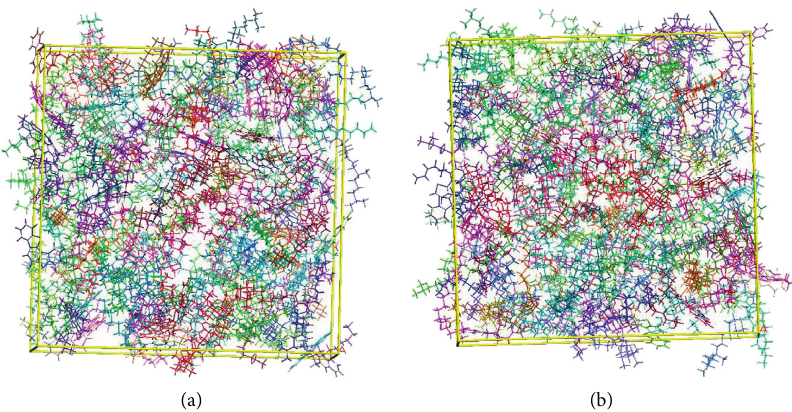
Figure 3: Illustration of low-sulfur fuel oil molecular structures at 298K (asphaltene: green, resin: orange, aromatic: blue, saturate: yellow, and hexadecane: pink). (a) Initial configuration. (b) Equilibrium configuration after 1 ns